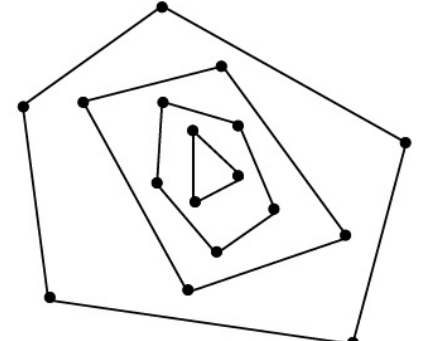
Figure 8: Convex layers expansion.